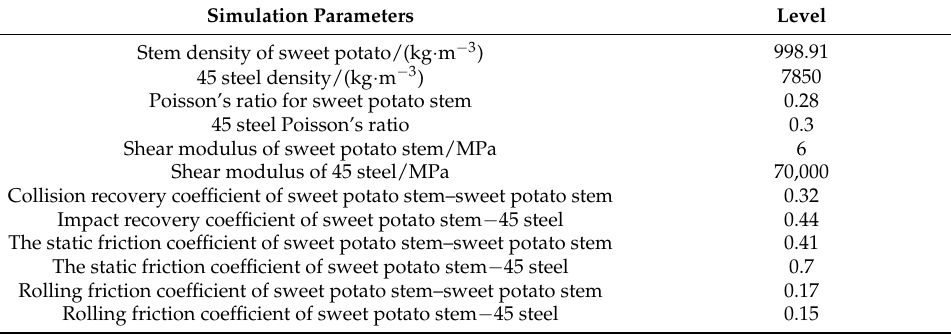
Figure 7. Three-point bending failure test of sweet potato vine stem: ( a ) bending failure simulation model; ( b ) bending failure test. Table 2. Discrete element simulation parameter values.